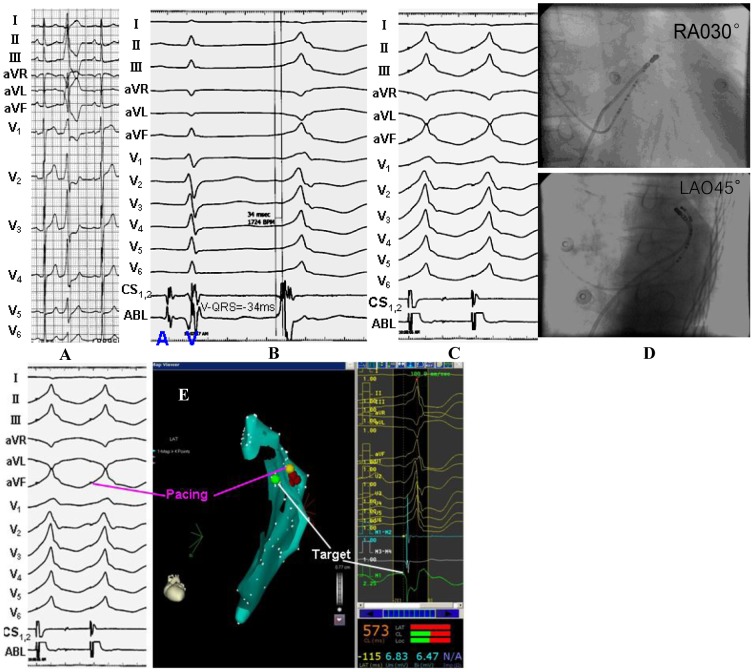
Example of a successful ablation of idiopathic premature ventricular contraction originating from the anterior portion of the epicardial mitral annulus.(A) The surface ECG characteristic. (B) The local ventricular activation time recorded at the successful ablation site that preceded the onset of the QRS complex was 34 ms. (C) Pace map at the ablation site. (D) The ﬂuoroscopic position of the ablation catheter site. (E) Green dot indicates site of RF application under the guide of Carto XP system.